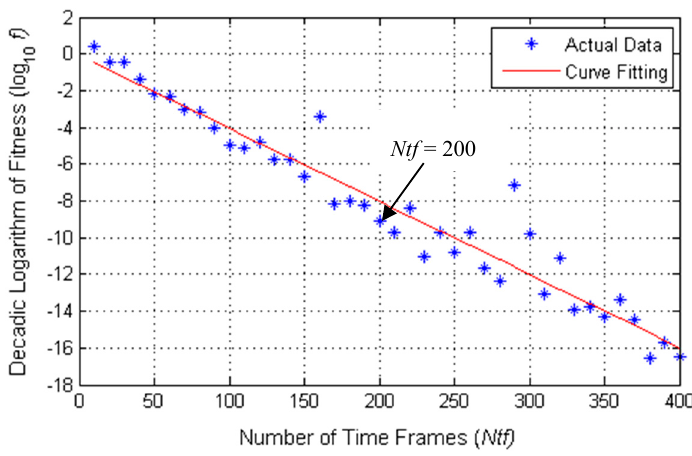
Figure 5. Fitness values expressed as decadic logarithmic error against swarm size.